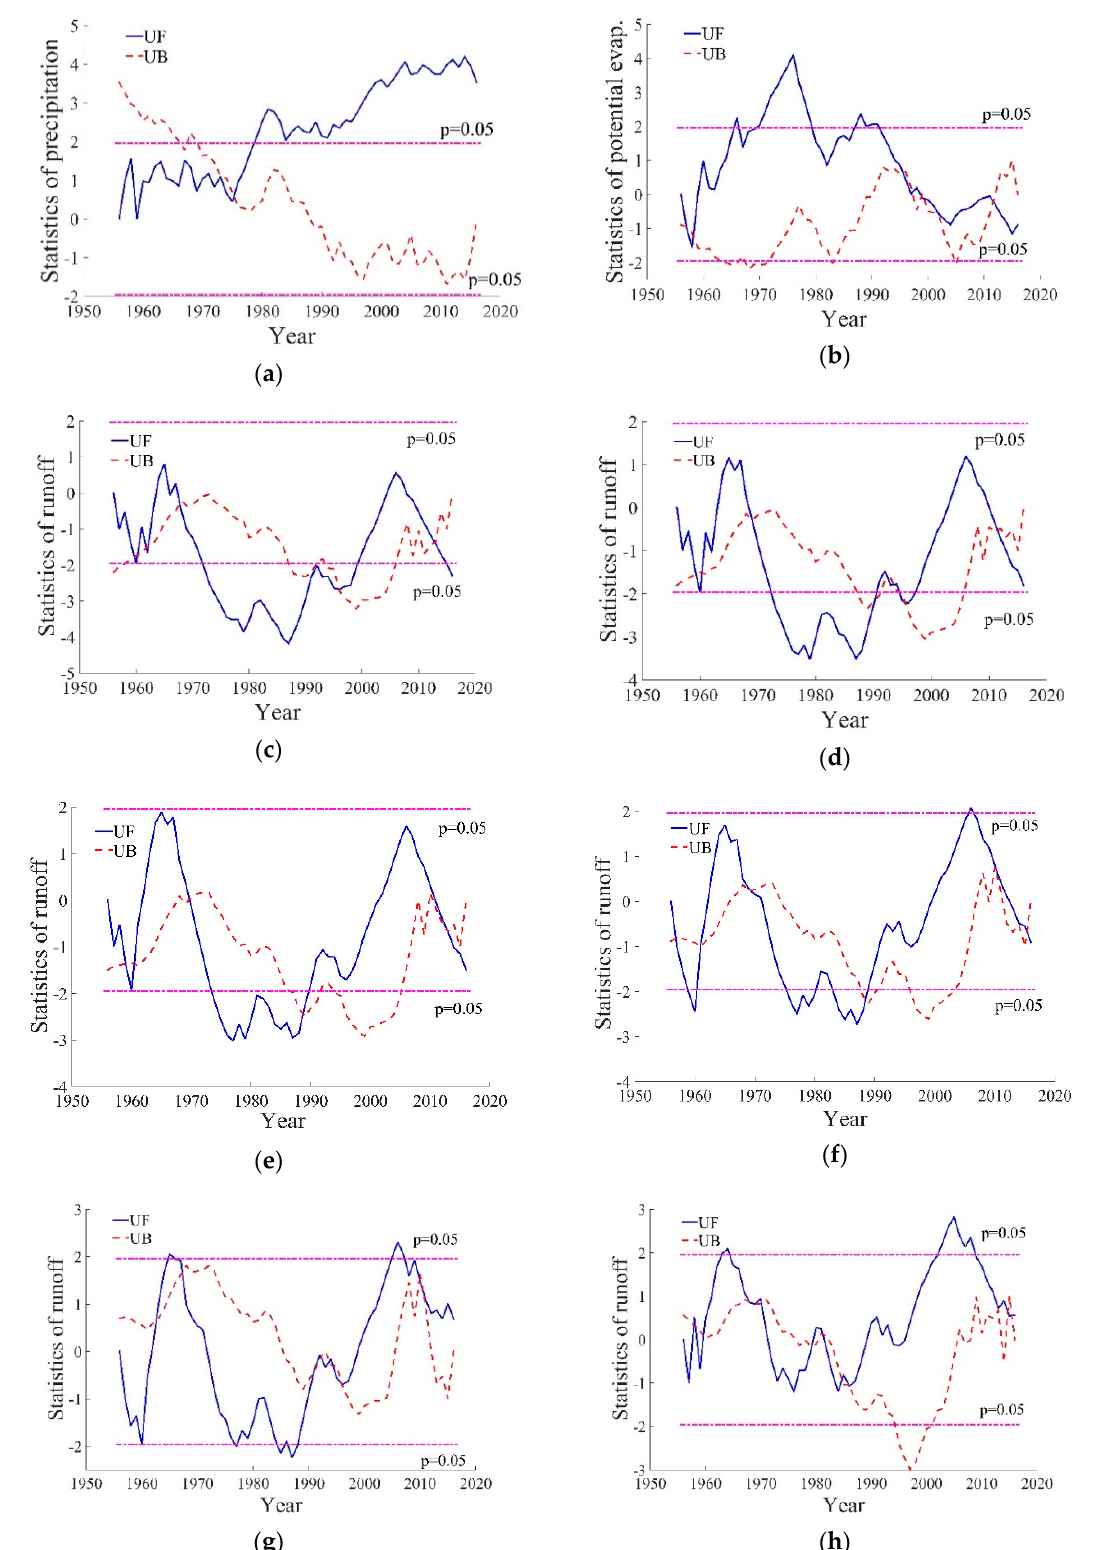
Figure 6. Mutation analysis using MK testing: ( a ) precipitation, ( b ) potential evapotranspiration, ( c ) annual minimum 1-day flow runoff, ( d ) annual minimum 3-day flow runoff, ( e ) annual minimum 7-day flow runoff, ( f ) annual minimum 30-day flow runoff, ( g ) annual minimum 90-day flow runoff, and ( h ) dry season runoff at Lhasa station in the dry season. UF and UB were calculated using the MK test in the forward and backward directions, respectively. Horizontal dashed lines are ±95% confidence intervals.